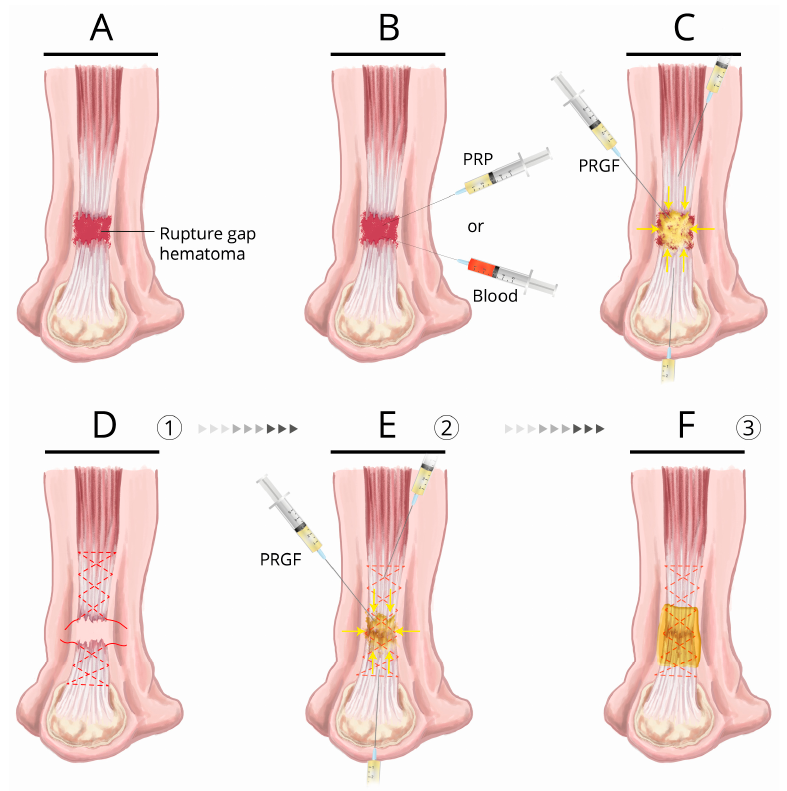
Figure 3. Achilles tendon rupture treatment: conservative and surgical treatment assisted by autolo- gous blood or blood-derived products (PRP). ( A ) Achilles tendon rupture, rupture gap, and hematoma. ( B ) Conservative treatment: a single injection of either PRP or autologous blood injected into the gap hematoma. ( C ) Conservative treatment proposal (in patients with a low functional demand, or for whom surgery is contraindicated). Ultrasound-guided injection of 4 mL of liquid plasma rich in growth factors (PRGF) in close proximity to the apparently healthy tendon tissue at each stump of the tendon and 4–6 mL of liquid PRGF into the gap hematoma; a procedure to be repeated over 2 or 3 consecutive weeks ( D – F ) Surgical treatment proposal: after the suture is performed with a non-reabsorbable suture material that has been bathed in liquid PRGF ( D ), 4–6 mL of liquid PRGF is injected in close proximity to the apparently healthy tendon tissue at each stump, as well as into the sutured area ( E ) within the time window of 10 to 15 min following PRGF activation with CaCl 2 . This window encompasses the time when the fibrin scaffold is still macroscopically liquid is but undergoing microscopic jellification. Liquid PRGF can extensively permeate through areas that sur- round the injection site and anchor to the collagen and other ECM proteins exposed in damaged tissue margins through the activated platelets conveyed by the fibrin clot, as a 3D fibrin–extracellu- lar matrix-like malleable structure [17], thereby bridging the gap of injured areas. The time window of 1–5 min is the result of the gel point or clotting time, meaning the change from liquid to solid undergone by the matrix when 15–20% of the fibrinogen has been incorporated into the gel by branching points (approximately 4 min 50 s) [46]. After closing the paratenon and prior to closing the overlying skin, the peritendinous regions are also infiltrated with PRGF; finally, the entire af- fected area of the tendon is covered with a fibrin membrane of PRGF ( F ). As general recommenda- tion, we suggest the use of 10 mL Luer lock-type syringes with 21G needles, since the use of small syringes means that large pressures are exerted on the ECM of the tissue during infiltration, thereby accounting for the focalized disruption of the ECM components (a desirable effect in some treatment protocols aimed at disrupting the neovascularization and neoinnervation present in some chronic tendinopathies) [7,42]. Upon infiltration, the needle should be oriented as closely as possible parallel to, and longitudinal with, the tendon fascicles for an optimal diffusion of PRGF [42].